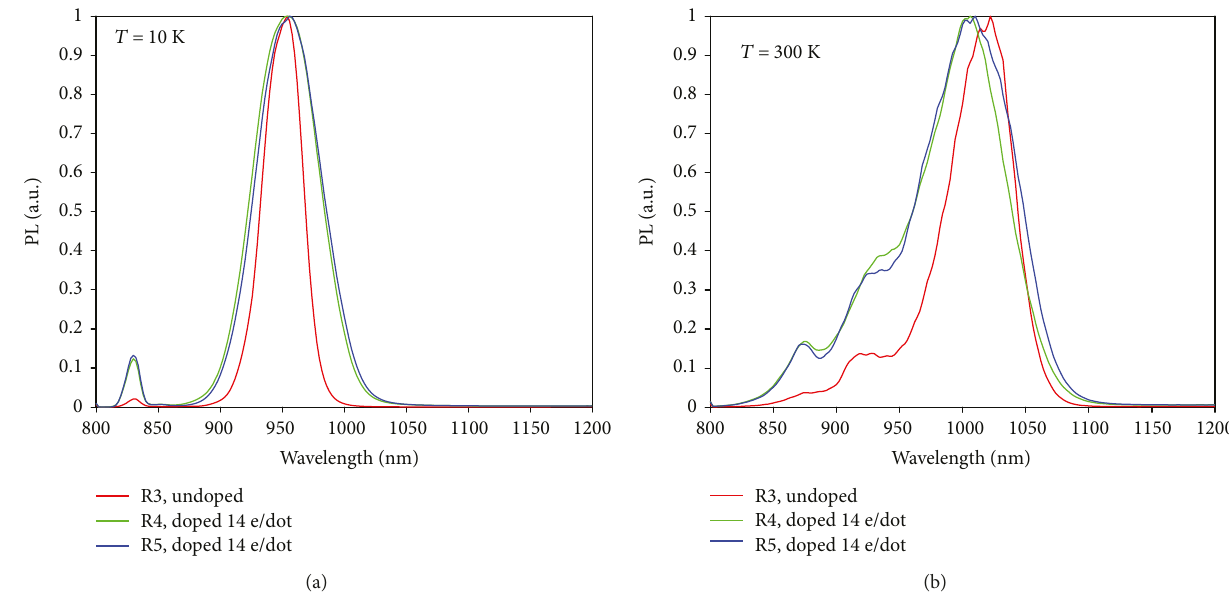
Figure 5: Normalized PL spectra measured at T =10K (a) and T =300K